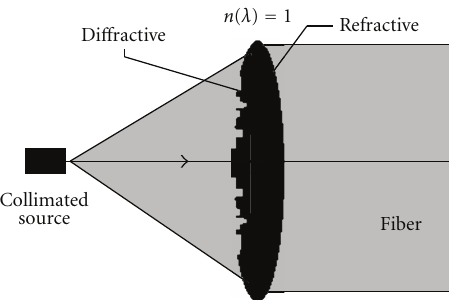
Figure 2: Axial chromatic aberration corrected hybrid lens (Refractive-Di ff ractive lens).